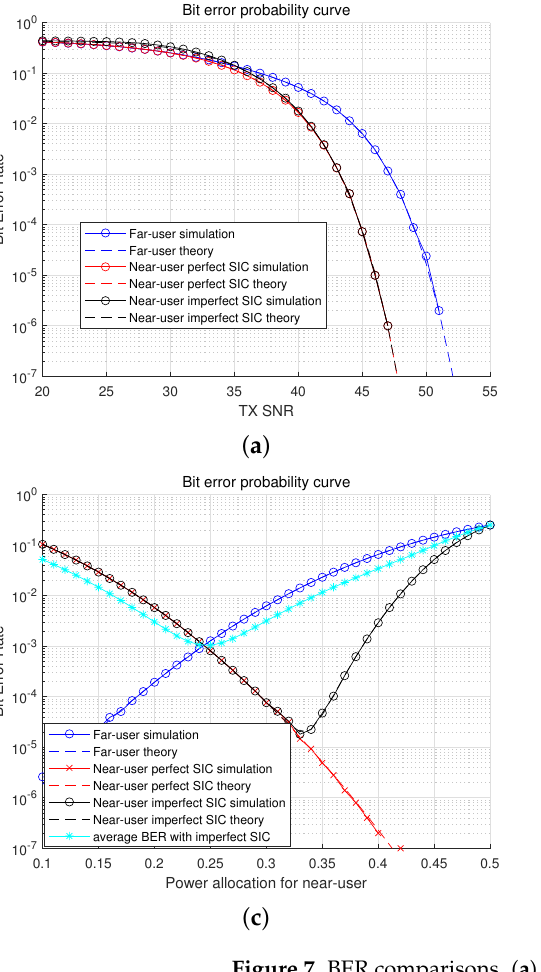
Figure 7. BER comparisons. ( a ) BER comparison. ( b ) BER comparison (Transmit SNR 40 dB). ( c ) BER comparison (Transmit SNR 45 dB). ( d ) BER comparison (Transmit SNR 50